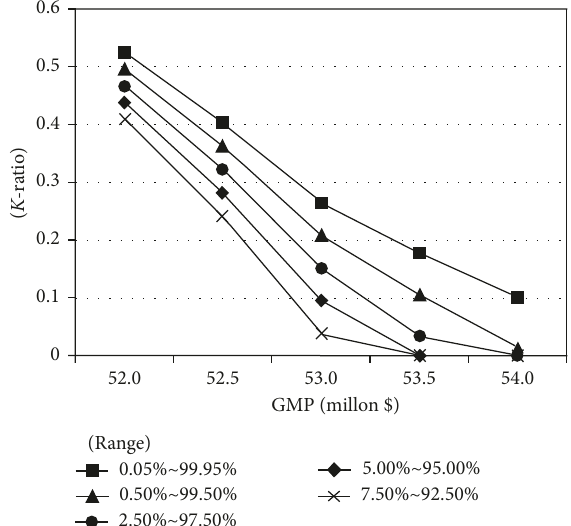
Figure 6: K -ratio at expected cost of $51 (million).